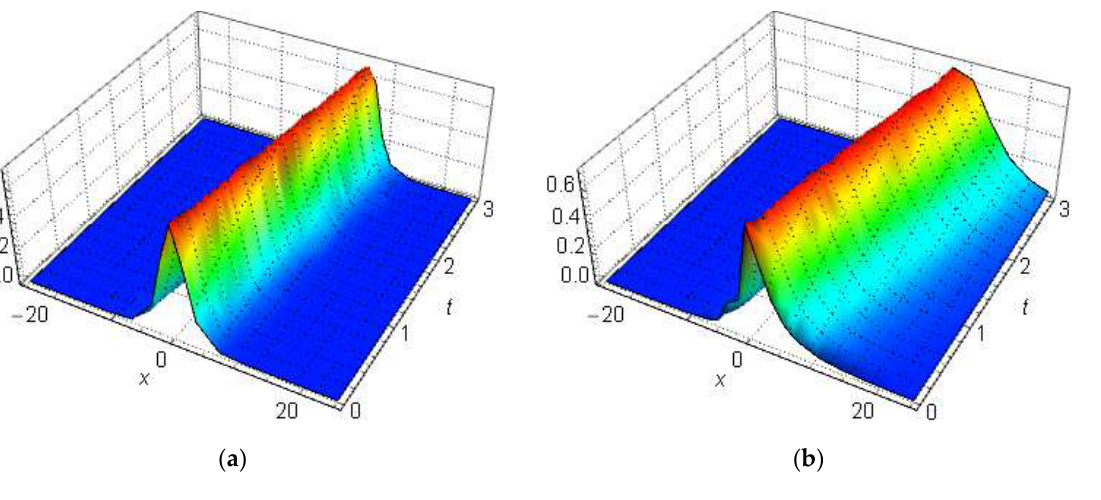
(cid:3002) (cid:3044) (cid:3118) , for (1) at 𝐴 = ℬ = 𝑎 (cid:2869) = 𝑞 (cid:2870) = (cid:3495) (cid:3081) (cid:2870)(cid:3044) (cid:3119)